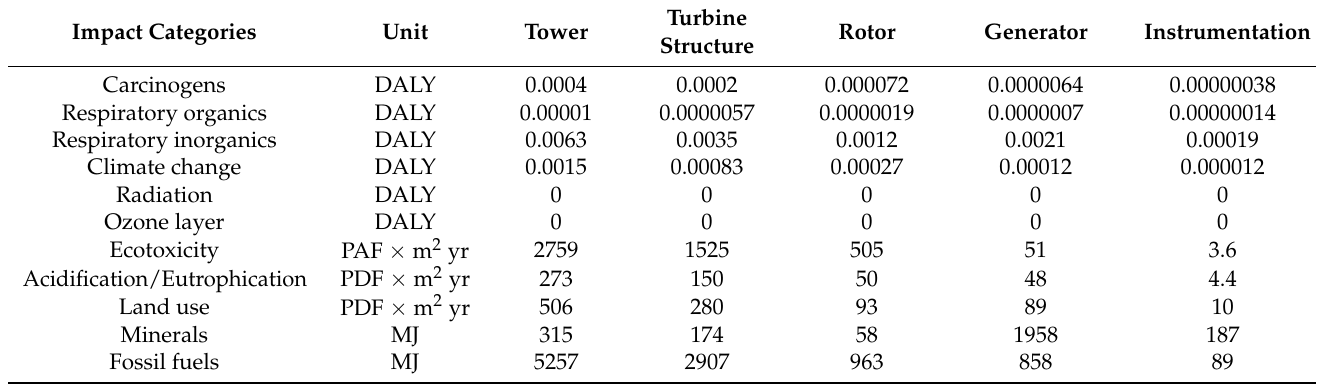
Table 2. Results of characterization of environmental consequences occurring in particular stages of the life cycle of an innovative 15 kW wind power plant, including categories of impacts without recycling.